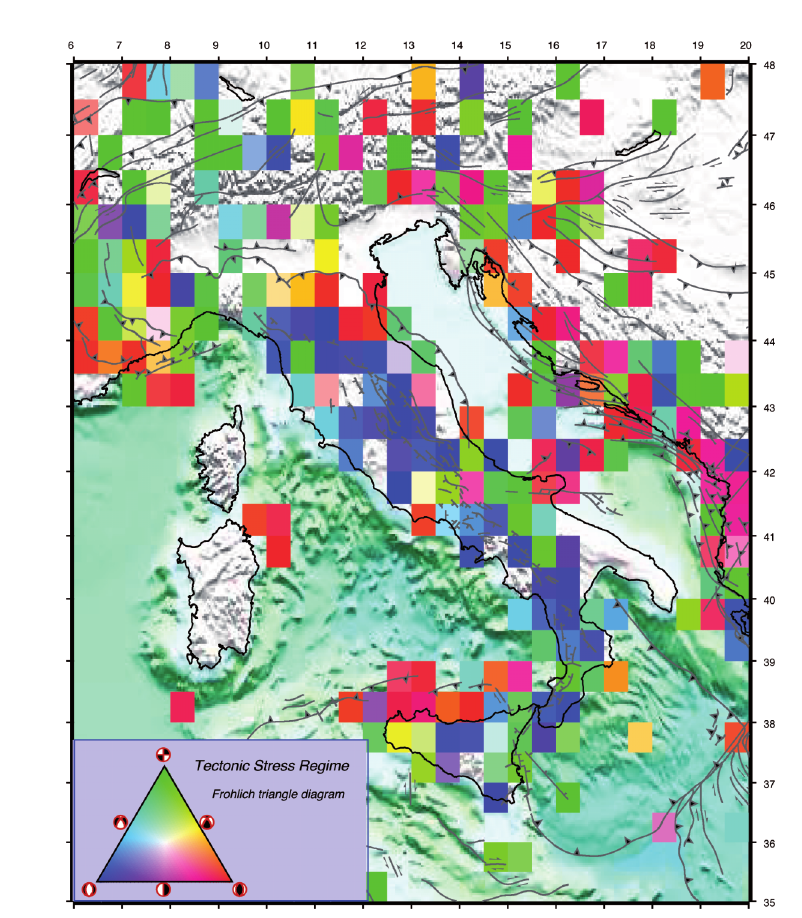
Fig. 6. Map showing the tectonic regime obtained using cumulative moment tensors, plotted following the Frohlich ternary diagram associated to a RGB representation. The data used to compute the cumulative moment tensors are the same as those of fig.